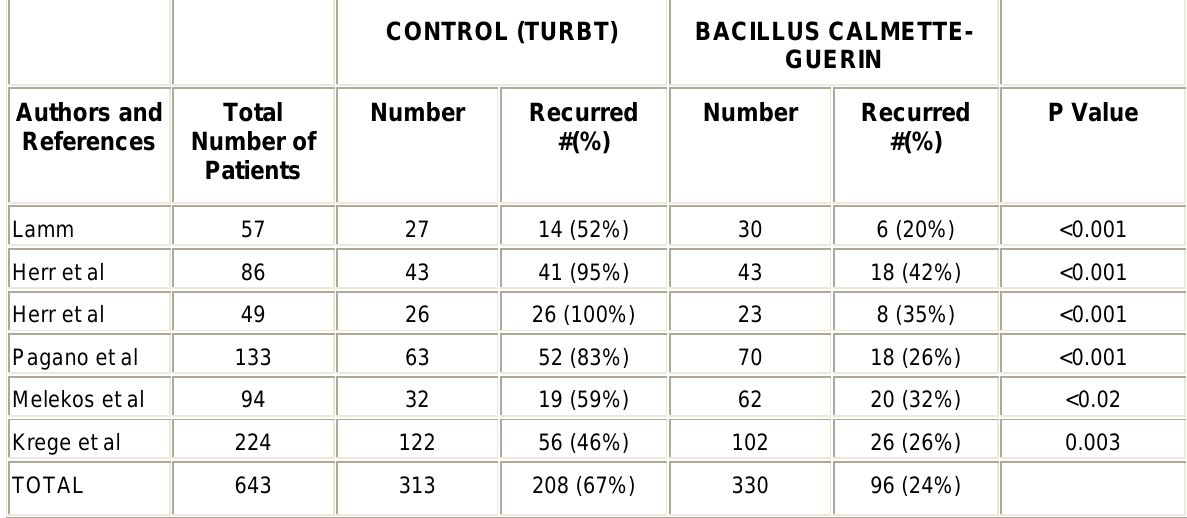
Effect of Intravesical Bacillus Calmette-Guerin on Recurrence in Control Studies CONTROL